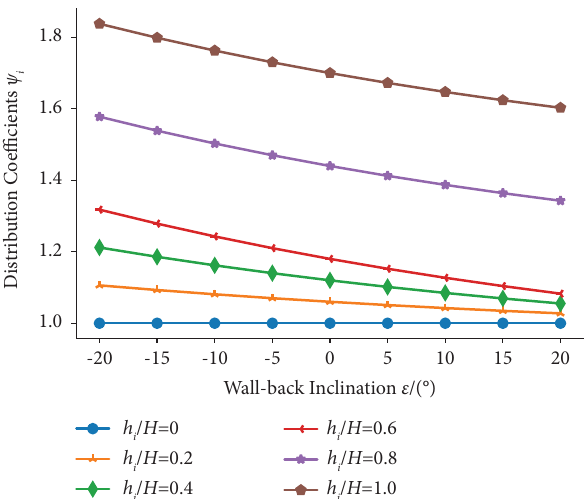
Figure 11: Relationship curve between the distribution coefcient and the wall-back inclination